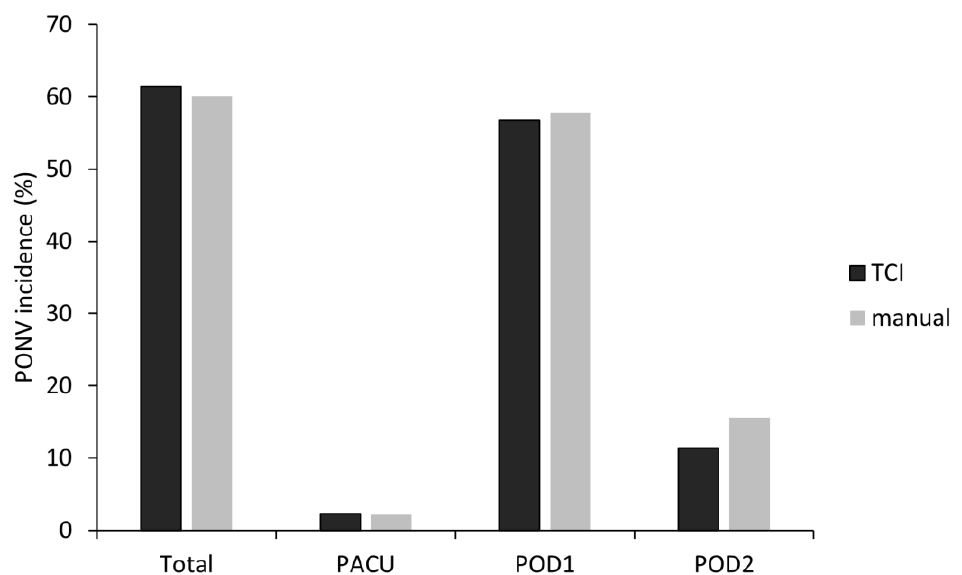
Figure 2. PONV incidence in total and different period. PONV, postoperative nausea and vomiting; TCI, target-controlled infusion; PACU, post-anesthetic care unit; POD, postoperative day.